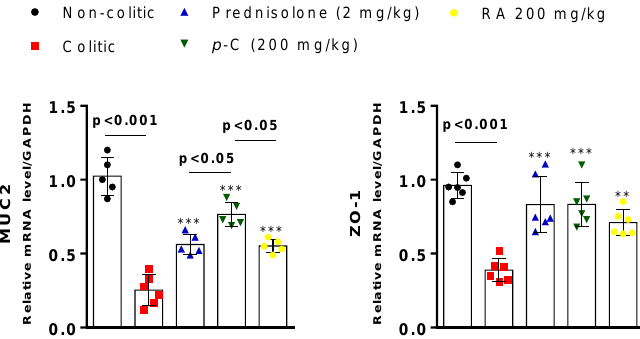
Figure 5. Effect of oral administration of p- C and RA in mucin type 2 (MUC-2) and zonula occludens 1 (ZO-1) expression in a TNBS-induced ulcerative colitis rat model. Data are expressed as mean of cell percentages ± standard error, having been analyzed by one-way ANOVA followed by Dunnett’s or Tukey’s test. *** p < 0.001, ** p < 0.01 compared to colitic control groups ( n = 5–6). Intense signs of MUC-2 depletion ( p < 0.001) from mucin-producing cells and ZO-1 redistribution ( p < 0.001) was observed by TNBS challenge in colitic animals when compared to healthy groups. On the other hand, oral treatment with p- C (200 mg/kg) or RA (200 mg/kg) reestablished ( p < 0.001) their immunolabeling close to baseline levels, as shown in Table 2 and Figure 6. Table 2. Effect of oral administration of p- C and RA on MUC-2 and ZO-1 immunostaining in colonic tissue from TNBS-induced ulcerative colitis rat model. Treatments